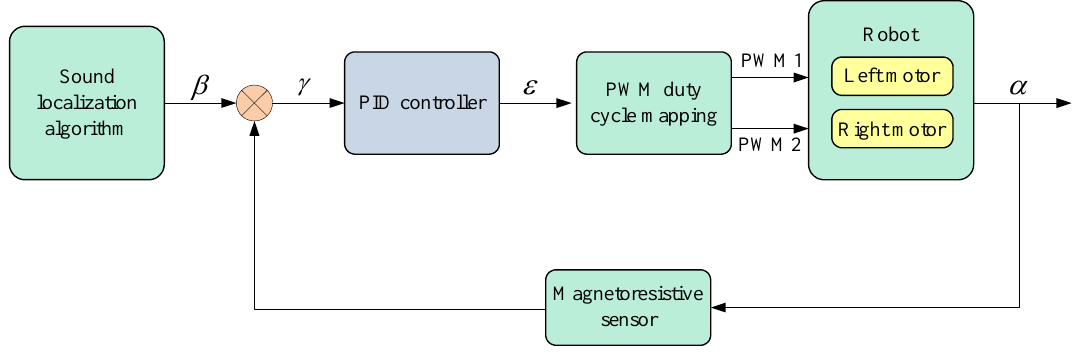
Figure 8. Closed-loop control diagram of hearing robot for sound